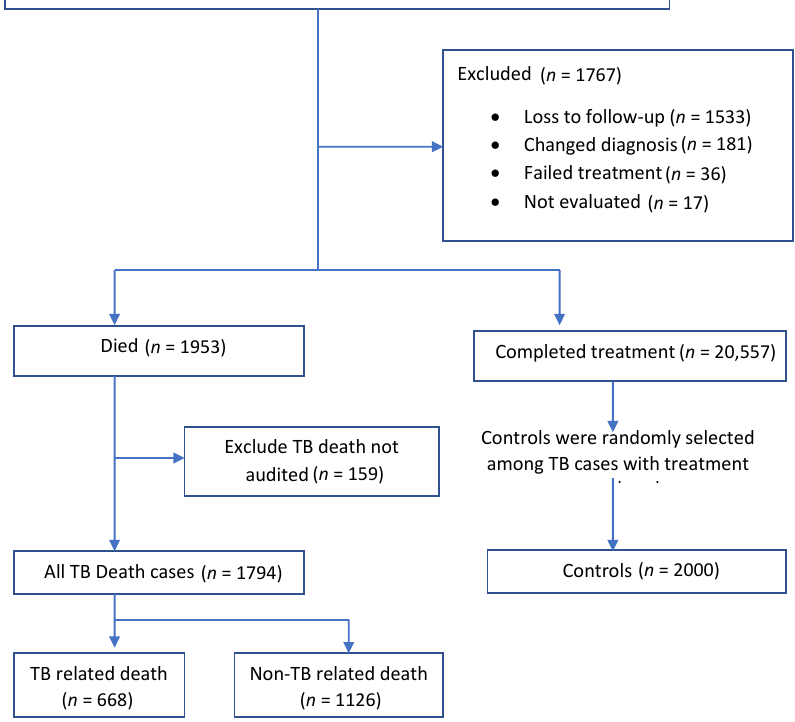
Figure 1. Selection of cases and controls from TB registry 2014 – 2018. Table 1. Characteristics of cases and controls.